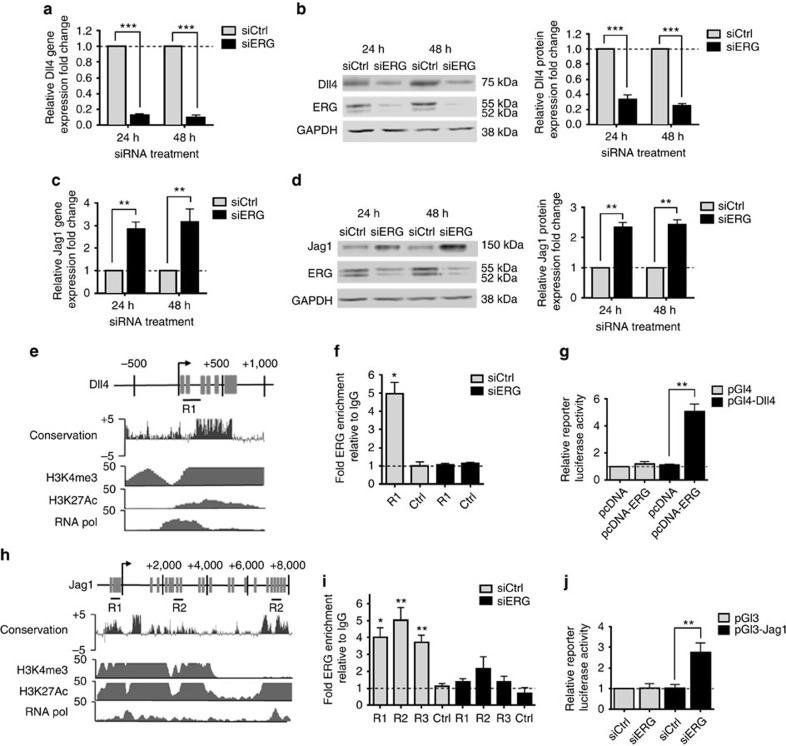
ERG transcriptionally activates Dll4 and represses Jag1 expression.(a) mRNA levels of Dll4 in HUVEC treated with siCtrl or siERG for 24 and 48 h (n=6). (b) Representative WB and quantification of Dll4 protein expression in siCtrl and siERG-treated HUVEC for 24 and 48 h (n=3). (c) mRNA levels of Jag1 in siCtrl and siERG-treated HUVEC for 24 and 48 h (n=6). (d) Representative WB and quantification of Jag1 expression in siCtrl and siERG-treated HUVEC for 24 and 48 h (n=6). (e) Putative ERG binding sites (grey bars) are located within the Dll4 promoter downstream of the transcription start site (TSS) (arrow); ENCODE sequence conservation between 100 vertebrates is shown across this region. ENCODE ChIP-seq data profiles for H3K4me3, H3K27Ac and RNA polymerase II (RNA pol) in HUVEC indicate open chromatin and active transcription. Location of qPCR amplicon covering region R1 is indicated. (f) ChIP-qPCR using primers to region R1 on ERG-bound chromatin from siCtrl or siERG-treated HUVEC. Primers for a region within exon11 of the Dll4 gene were used as negative control. Data are shown as fold change over IgG (n=3). (g) Dll4 promoter luciferase reporter assay. ERG cDNA expression plasmid (pcDNA-ERG) or empty expression plasmid (pcDNA) were co-transfected with a Dll4 promoter-luciferase construct (pGl4-Dll4, covering region R1) in HUVEC, and luciferase activity was measured. Values represent the fold change in relative luciferase activity over the empty pGL4 vector alone (n=4). (h) Putative ERG binding sites (grey bars) located within the Jag1 genomic locus. TSS is indicated (arrow); ENCODE sequence conservation between 100 vertebrates and ChIP-seq data profiles for H3K4me3, H3K27Ac and RNA polymerase II in HUVEC are shown across this region. Location of qPCR amplicons covering R1, R2 and R3 are indicated. (i) ChIP-qPCR using primers covering Jag1 promoter regions R1, R2, R3 and Ctrl region on ERG-bound chromatin from siCtrl or siERG HUVEC (n=4). (j) Control or Jag1 promoter luciferase construct (pGl3-Jag1, covering regions R1 and R2) activity after siERG treatment. Results are expressed as luciferase activity relative to siCtrl-treated cells (n=3). All graphical data are mean±s.e.m., *P<0.05, **P<0.01, ***P<0.001, Student’s t-test.